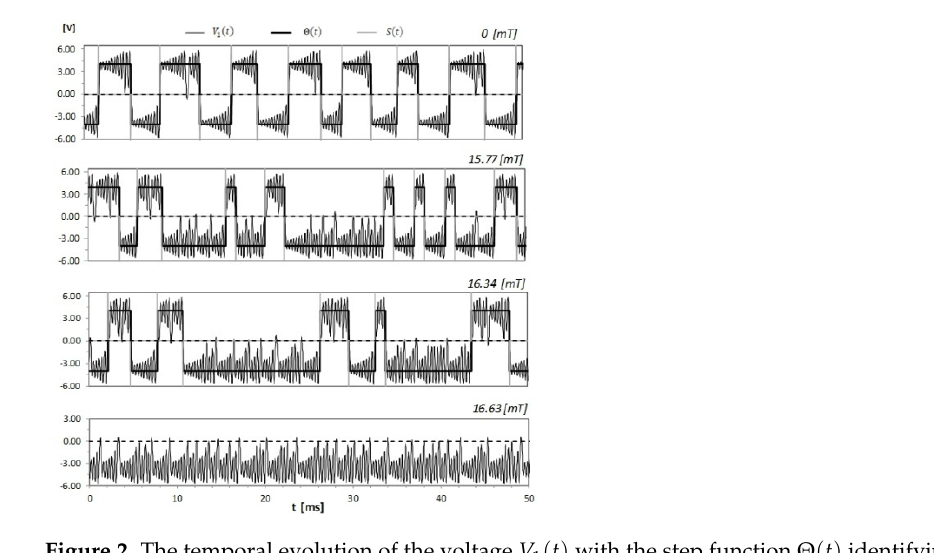
Figure 2. The temporal evolution of the voltage V 1 ( t ) with the step function Θ ( t ) identifying scrolls and its derivative - the spike function S ( t ) identifying crossing points between scrolls for R = 1580 Ω and different static magnetic field intensities.